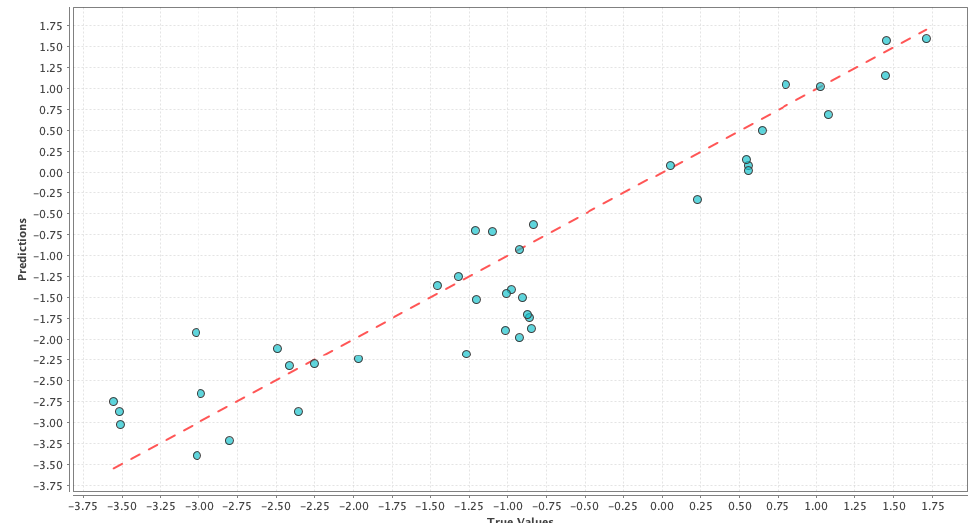
Figure 9. Result on Test Set For Deep Learning using Model 10 from Table 3. The x-axis represents the true or the actual PDSI values and the y-axis represents the predicted PDSI values. Each small blue circle in the figures is represented by the tuple ( PDSI actual , PDSI pred ). The red dashed line is the reference line to test the model